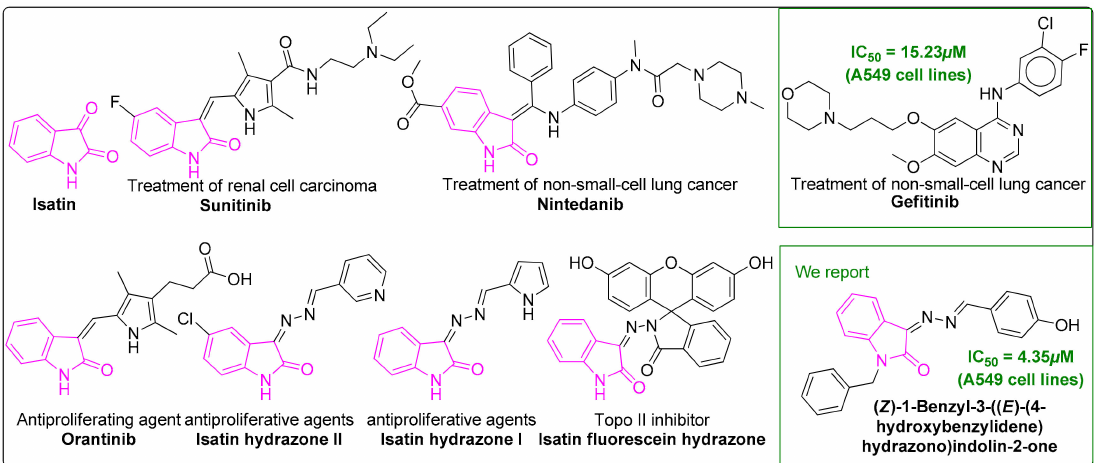
Figure 1. Isatin moiety containing active & potential drugs and